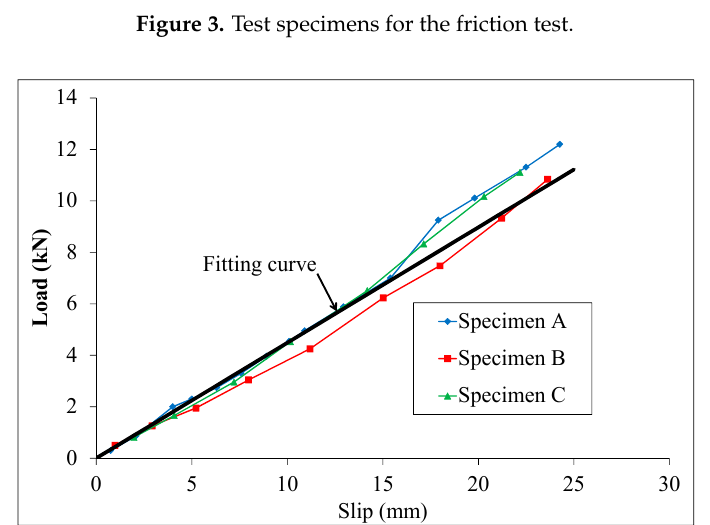
Figure 4. Load-slip curves of the specimens without studs.